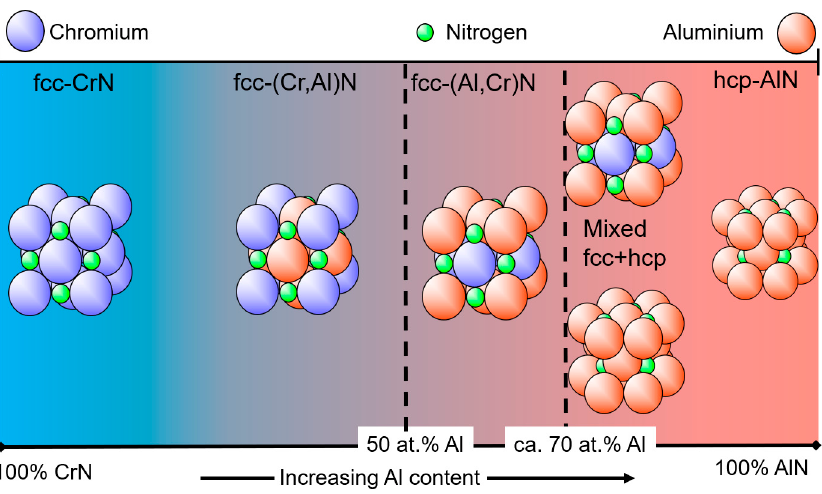
3 Figure 3. Schematic diagram showing the basic crystal structure of (CrAl)N and (AlCr)N coatings as a function of the Al